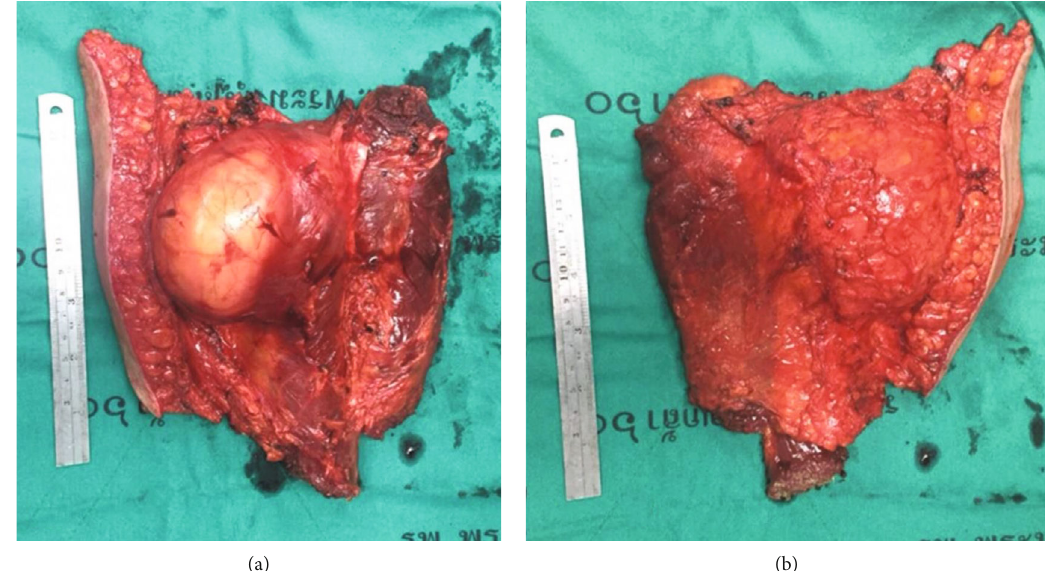
Figure 3: Complete surgical removal of tumor.